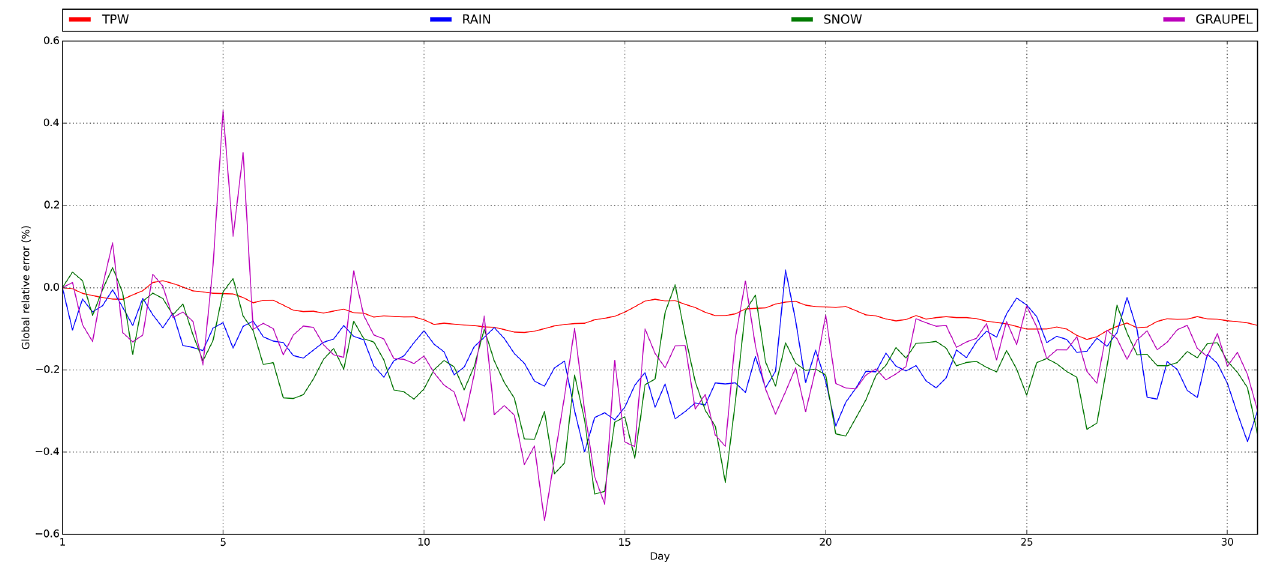
Figure 8. Relative error for mean domain tracer TPW (red), 3h accumulated tracer rain (blue), tracer snow (green) and tracer graupel